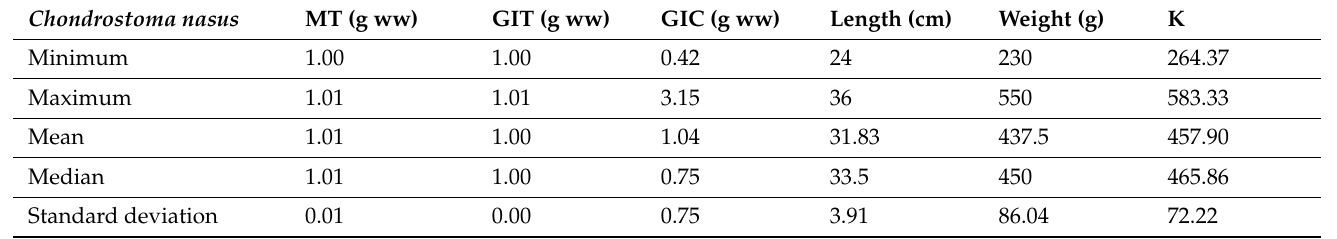
Table 1. Chondrostoma nasus measurements; gastrointestinal tissue (GIT), the gastrointestinal content (GIC) and muscle tissue (MT).